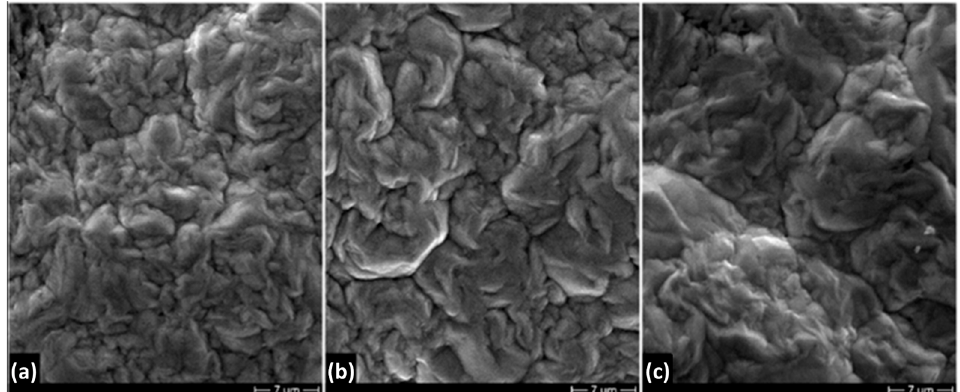
Figure 8. Morphology of deposits obtained at different current densities ( a ) 500 A/m 2 , ( b ) 750 A/m 2 and ( c ) 1000 A/m 2 at 20 °C.